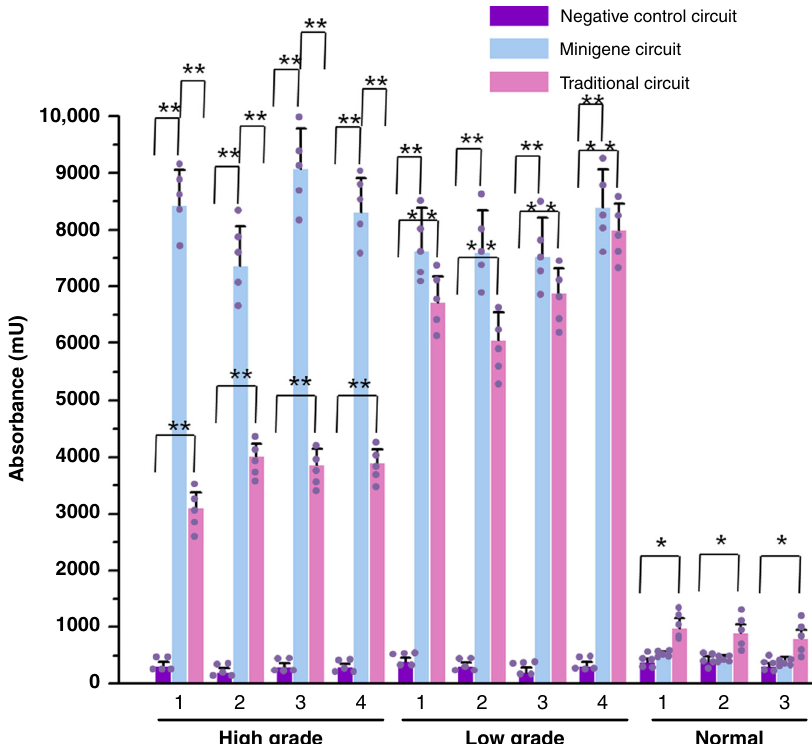
Fig. 2 The apoptosis levels of bladder cell lines transfected with either the minigene circuit or the traditional circuit. The level of cell apoptosis was calculated using the Cell Death Detection ELISA assay. Results are shown as the mean ± SD. The minigene circuit without output gene was used as the negative control. Each experiment was performed in triplicate for fi ve independent times. Each error bar indicates the variation (standard deviation) between the means of fi ve independent experiments. The small purple dots represent the mean of each independent experiment. The numerical category label represented the number of the corresponding cell line in each group. mU = absorbance [10 − 3 ]. * p < 0.05 and ** p < 0.01 between the groups using a two-tailed t -test. Exact p- values for asterisks (from left to right): 0.0002, 0.0056, 0.0043, 0.0005, 0.0041, 0.0061, 0.0001, 0.0047, 0.0052, 0.0002, 0.0045, 0.0058, 0.0006, 0.0008, 0.0005, 0.0009, 0.0005, 0.0007, 0.0003, 0.0004, 0.025, 0.031, and 0.035. Source data are provided as a Source Data fi